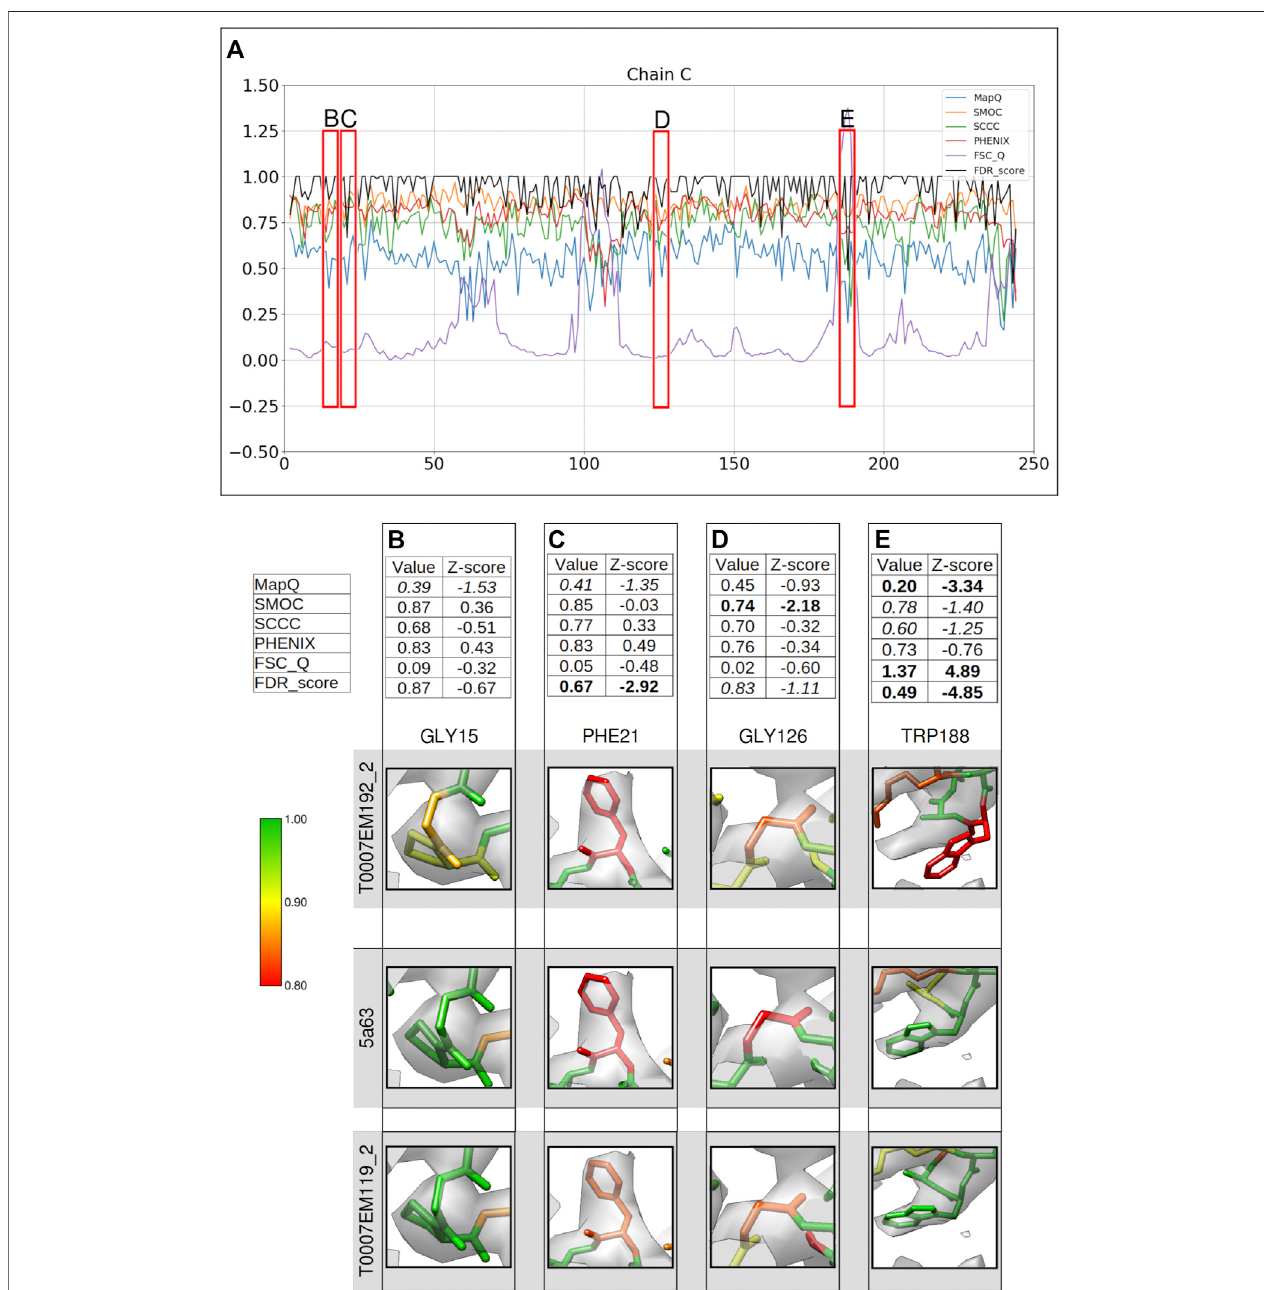
FIGURE 4 | Comparison of metrics for the atomic model of γ -secretase, calculated only for the backbone atoms. (A) Comparison of per-residue scores from MapQ, SMOC, SCCC, PHENIX, FSC-Q, and FDR backbone score for the chain C of the atomic model T0007EM192_2from the EMDB model challenge; the red boxes highlight the residues selected for detailed analysis in the panels below. For Gly 15 (B) , Phe 21 (C) , Gly 126 (D), and Trp 188 (E) , the panel shows a table with values of scoresobtainedwitheachmetricandcorrespondingZ-scores;theresidue fi tinthetargetmap(EMD-3061,grey)displayedattherecommendedcontourleveland renderedinUCSFChimera( fi rstrow);theresidue fi tinmapasmodeledinthereference(PDBID:5a63,center),andthe fi tofmodelT0007EM119_2inthemap(lastrow).